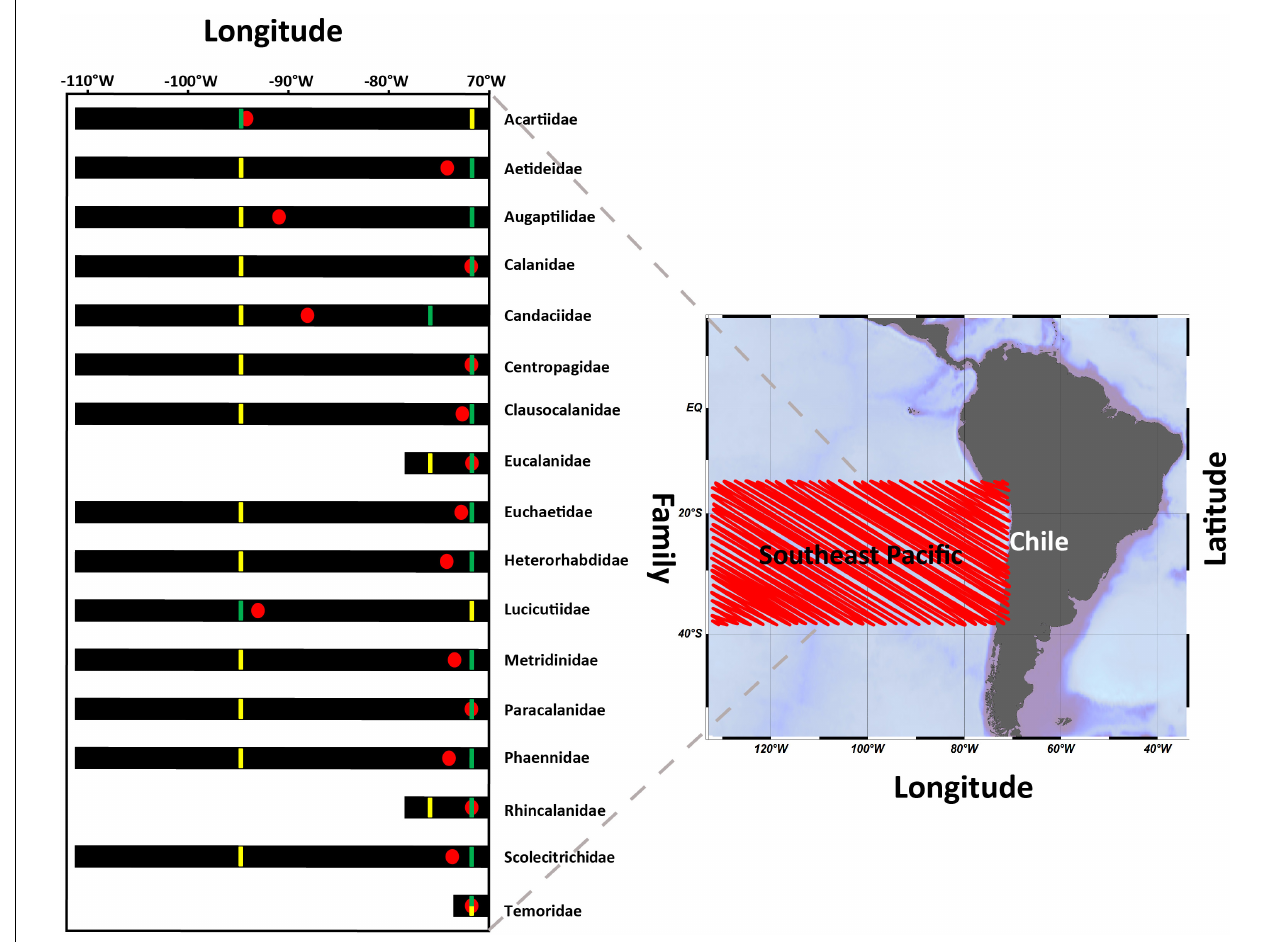
FIGURE 2 | Mean distribution of families in the 0–200 m layer across a longitudinal gradient from the coastal zone of Chile to Easter Island, between the years 2002 and 2015. For each family, the location of the onshore-offshore weighed abundance is shown (ZWA: ), the greatest abundance ( ), lowest abundance ( ) and range of distribution (